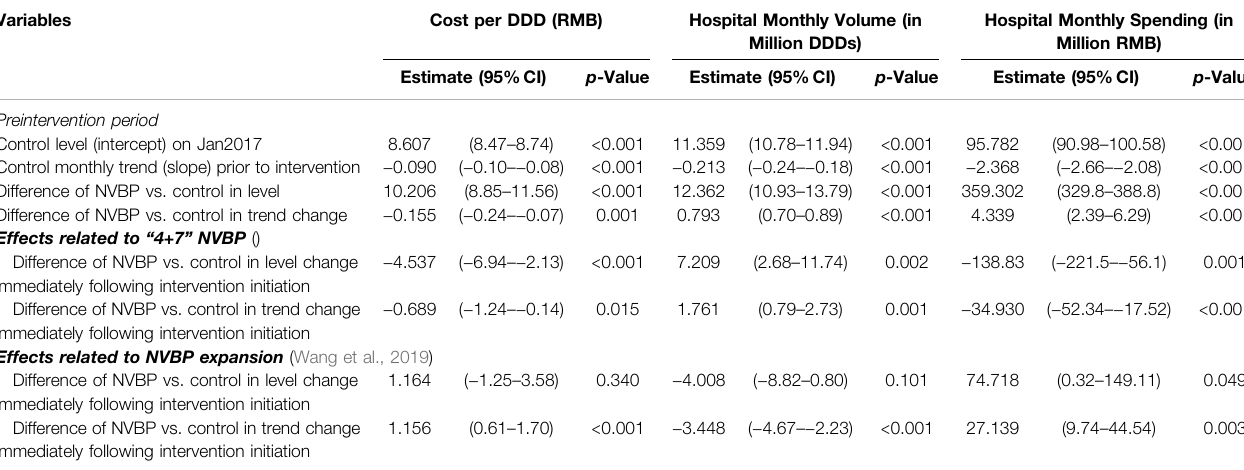
TABLE 2 | Secondary analysis of ITS with a control group on cost per DDD, procurement volume, and procurement spending for antivirals a .